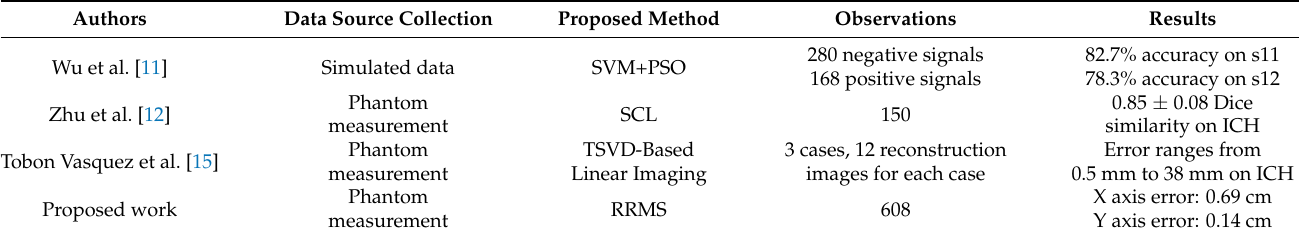
Table 3. Comparison with existing